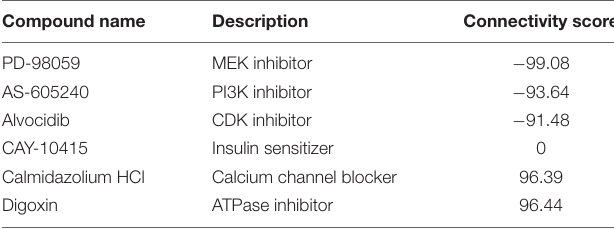
TABLE 2 | Overview of compounds identified with CMap and selected for further